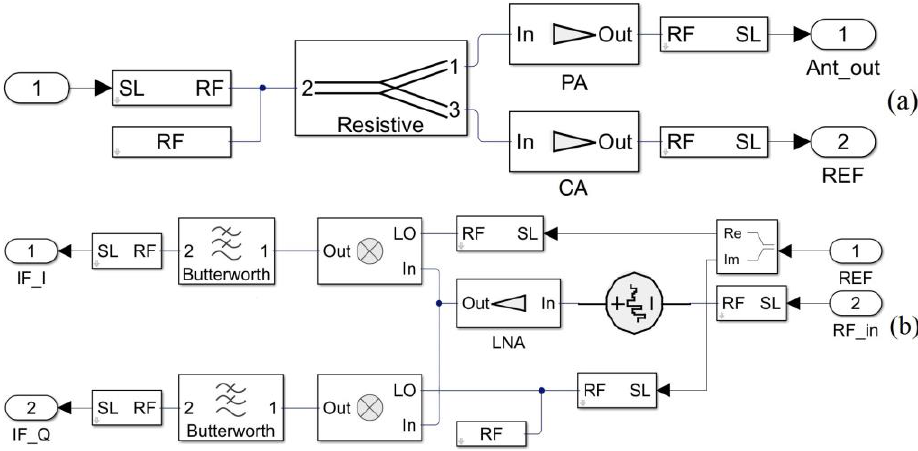
Fig. 7. Transmitter (a) and Receiver (b)